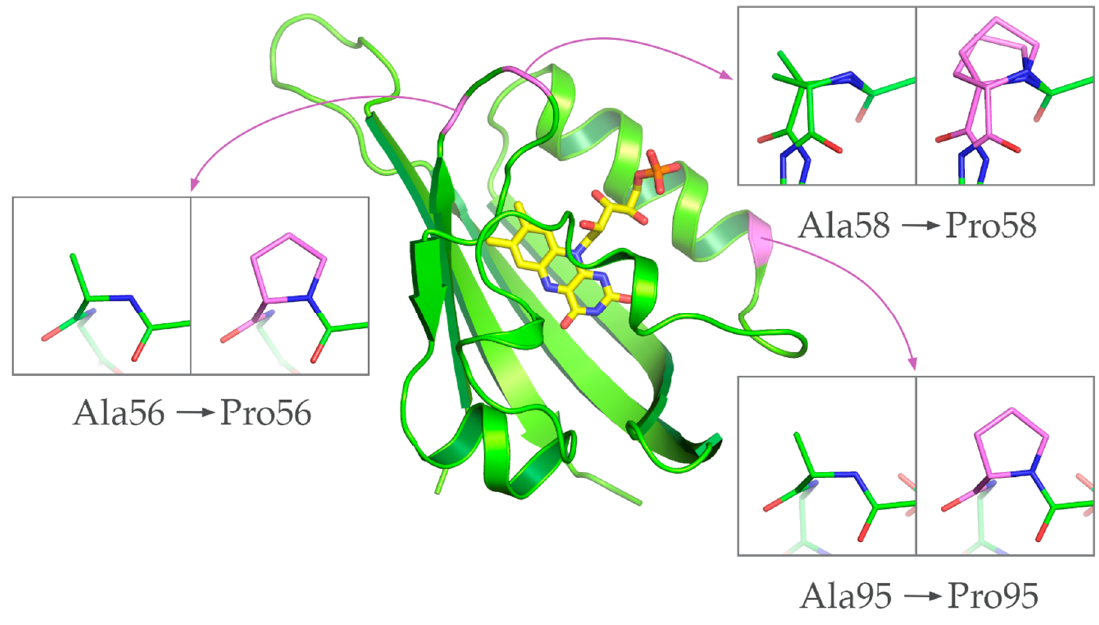
Figure 2. Location of the prospective proline substitution sites (magenta, modeled using PyMOL [48]) mapped onto the CagFbFP structure (green, PDB ID 6RHF). Ala58 (top right) adopts two alternative conformations in the original structure [25].